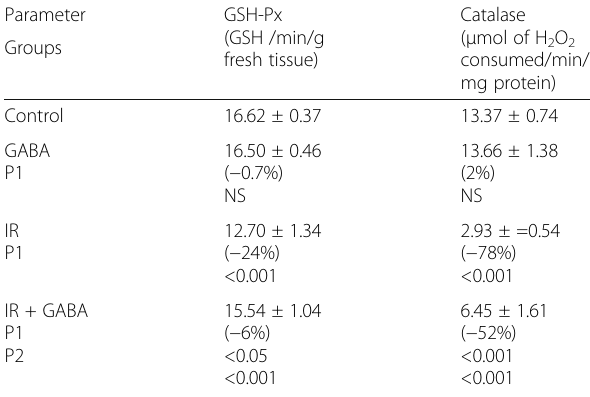
Table 4 Influence of GABA (200 mg/Kg b.wt; 3 weeks) on antioxidants biomarkers values in jejunum of 6 Gy whole body gamma-irradiated rats